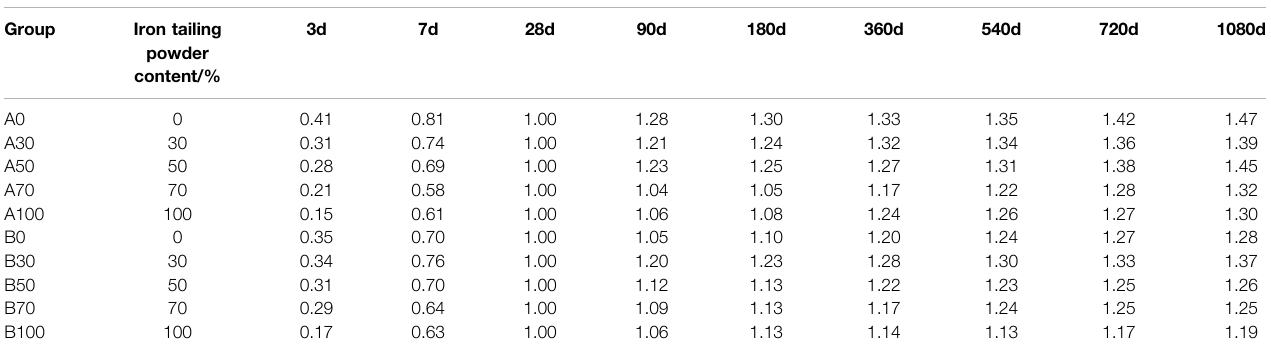
TABLE 9 | Relative compressive strength of iron tailing powder concrete.